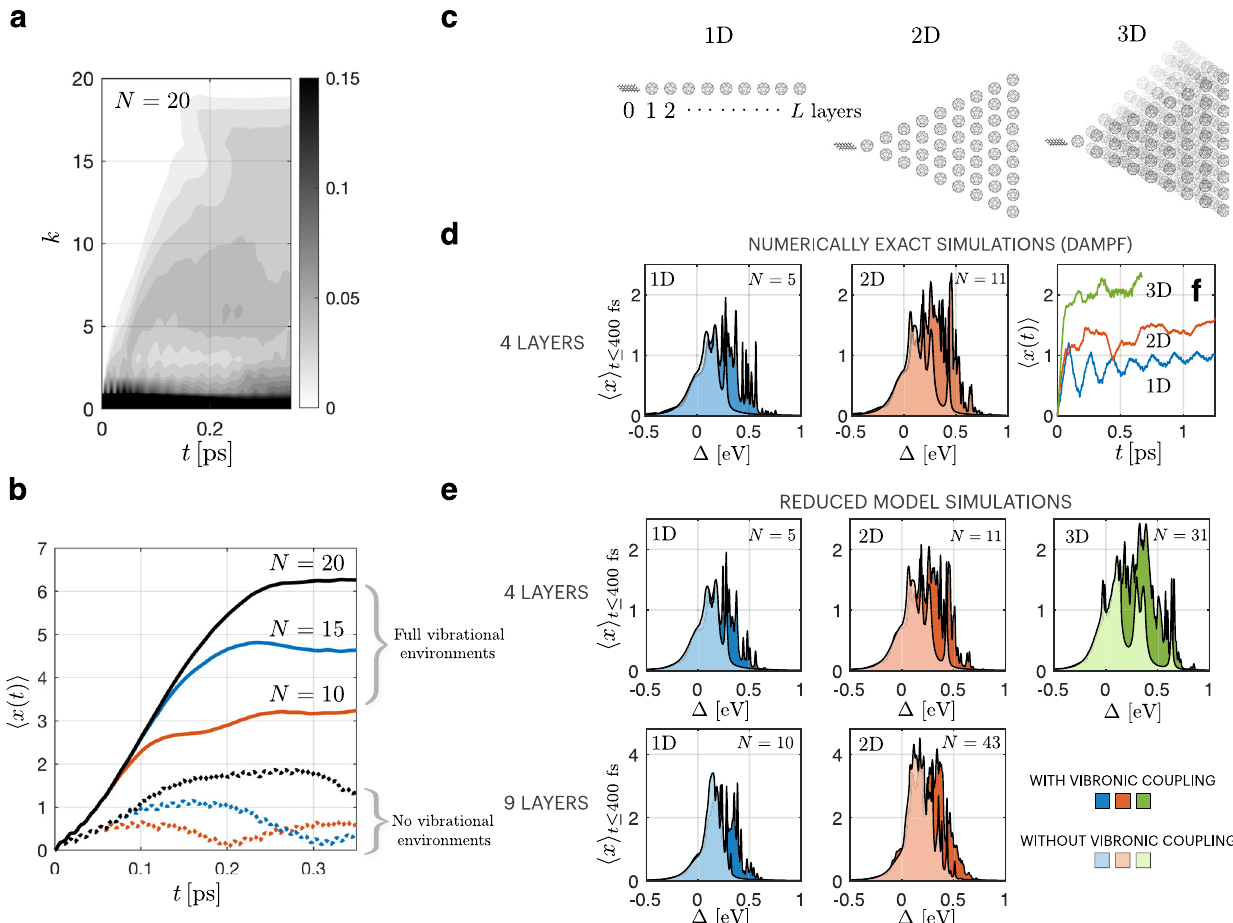
Fig. 5 Charge separation in large vibronic systems in one, two and three spatial dimensions. a With a hole fi xed at donor, the probability distribution for fi nding an electron at the donor ( k = 0) or at the k th acceptor ( k ≥ 1) is shown as a function of time t for a linear chain consisting of N = 20 sites (the colorbar quanti fi es these probabilities). Here electronic states are coupled to total vibrational environments ( J ð ω Þ ¼ J l ð ω Þ þ J h ð ω Þ ) including weakly damped high-frequqency modes with ω h = 1500 cm − 1 and γ = (500 fs) − 1 . b Mean electron – hole distances 〈 x ( t ) 〉 of linear chains composed of N ∈ {10, 20, 30} sites, shown in {red, blue, black}, respectively. Here we compare the case of the full environments, shown in solid lines, with that of no vibrational environments ( J ð ω Þ ¼ 0), shown in dashed lines. c Schematic representation of one-, two- and three-dimensional donor – acceptor networks where a donor is coupled to acceptor aggregates. d Time-averaged mean electron – hole distances 〈 x 〉 t ≤ 400fs of one- and two-dimensional networks consisting of L = 4 acceptor layers, displayed as a function of driving force Δ and computed by the Dissipation-Assisted Matrix Product Factorization method (DAMPF) 59 . Here the case with vibronic coupling to high-frequency modes is shown in blue, red and green for the one-, two- and three dimensional models respectively. The case with no environments is shown in a lighter tone. Note that the overlapped regions indicate that the case without environments is well covered by the vibronic case. e Time-averaged mean electron – hole distances of one-, two- and three-dimensional networks consisting of L = 4 or L = 9 acceptor layers, simulated by a reduced vibronic model (see Supplementary Note 4 for more details). For the three-dimensional network with L = 4, 〈 x 〉 t ≤ 400fs is maximized at high driving forces Δ ≈ 0.35 eV. f For Δ = 0.35 eV, time evolution of mean electron – hole distance 〈 x ( t ) 〉 is shown for one-, two- and three-dimensional networks with L = 4, computed by